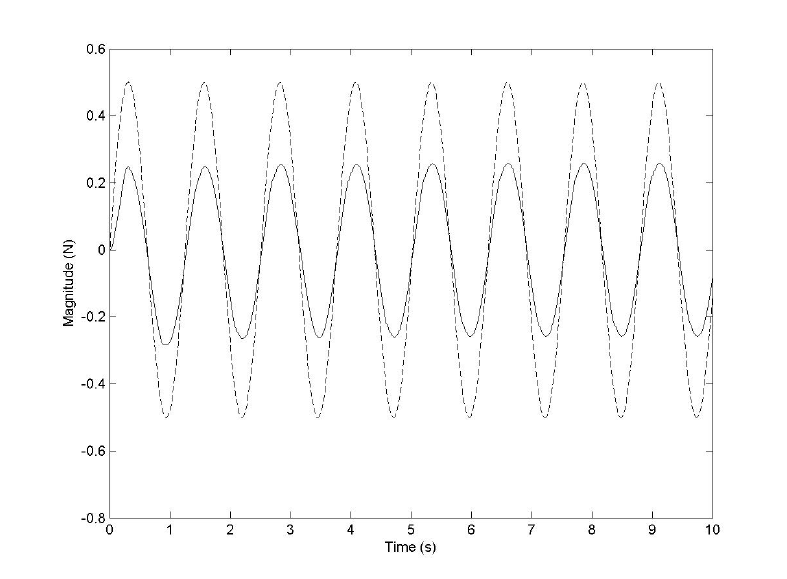
Fig. 21. Transmitted force variations of the system using the PID controller subjected to periodic engine disturbance at 1 Hz. Open loop (–) and PD controlled